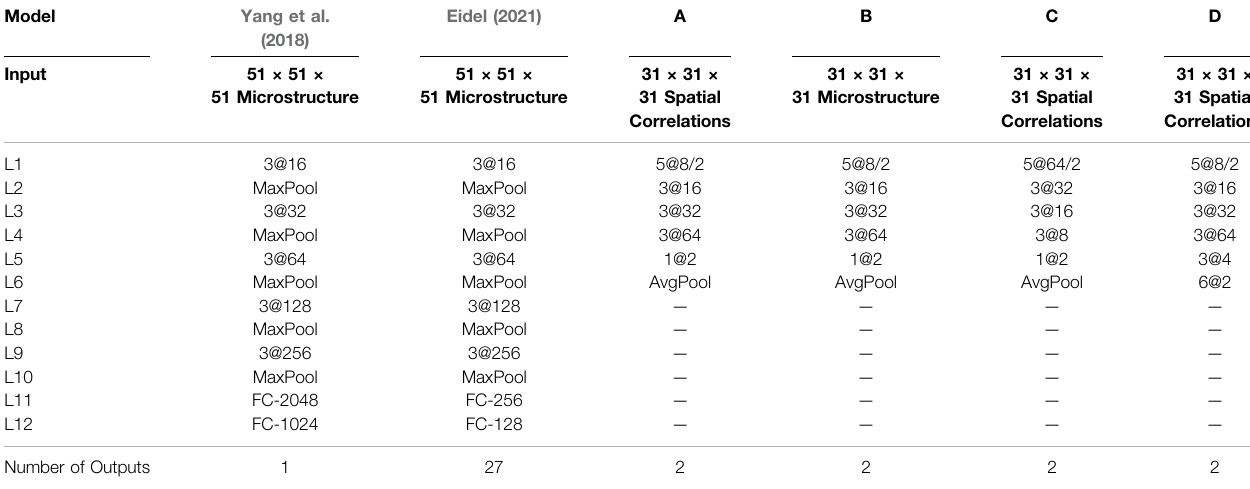
TABLE 1 | Examples of different CNN architectures explored in this work along with the relevant benchmarks from literature. The notation a@b/c indicates a axaxa kernel, applied with a stride of c, and b channels. The default value of stride, when not mentioned, is one.